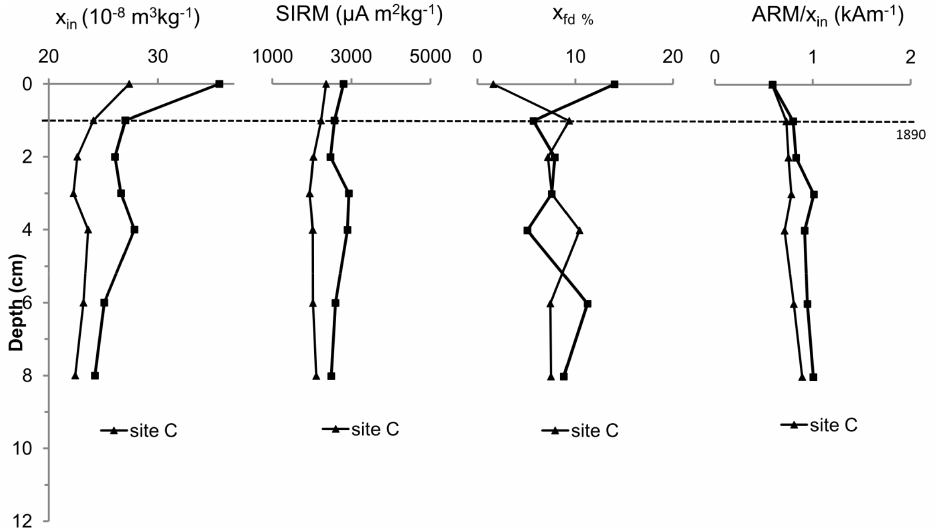
Figure 7. Vertical distribution of χ and D shown on Figure 4. Horizontal line shows the horizon of surface sediment about 100 years ago.